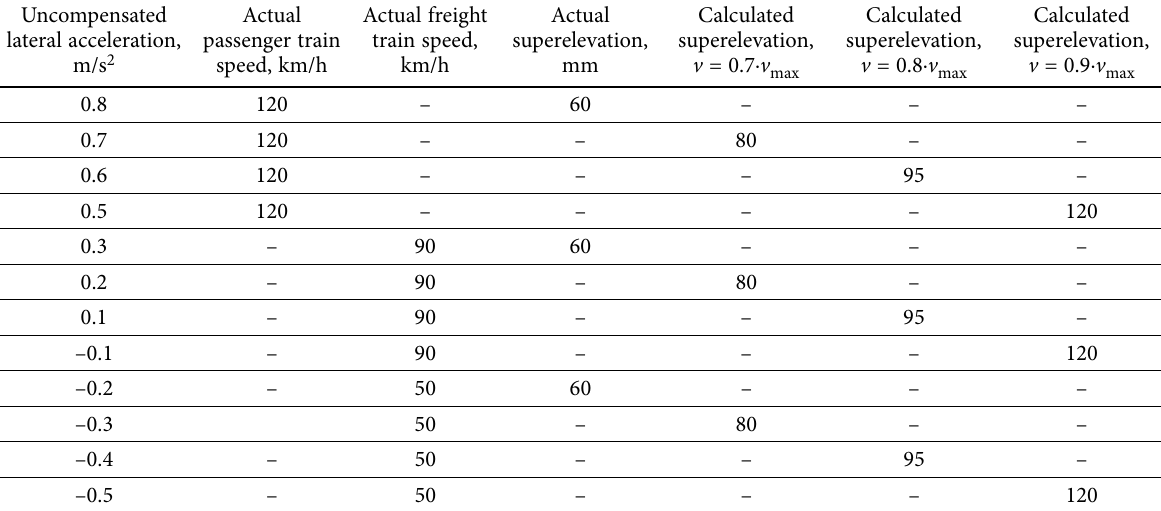
Table 2. Modelling superelevation and uncompensated lateral acceleration Uncompensated lateral